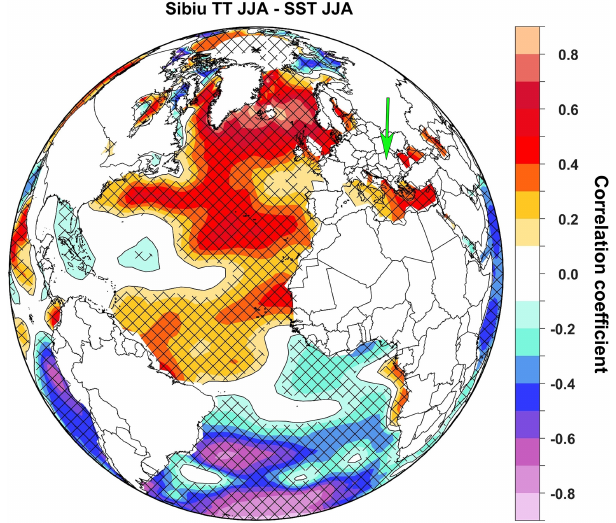
Figure 5. Spatial correlation map between sea surface temperature (SST) and average summer (JJA, June–July–August) air tempera- ture at Sibiu (60km south of Focul Viu Ice Cave, indicated by the green arrow) over the 1850–2011CE